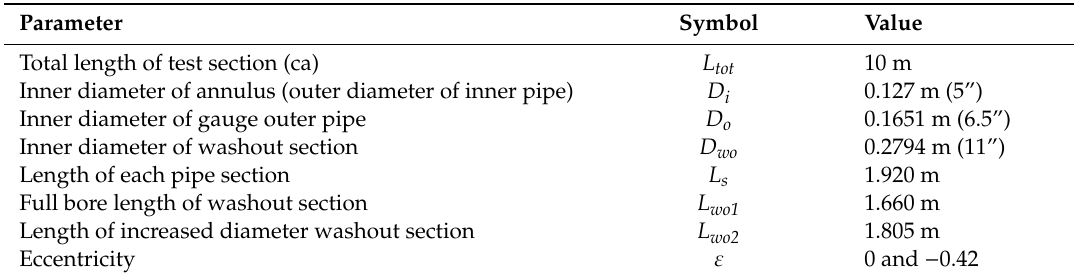
Table 2. Flow rig key parameters (see Figure 2).